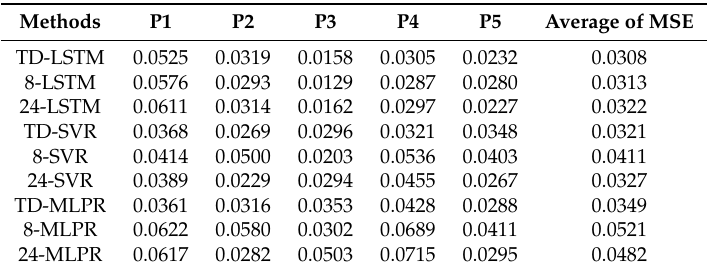
Table 1. Comparison of SST predictions in the coral sea